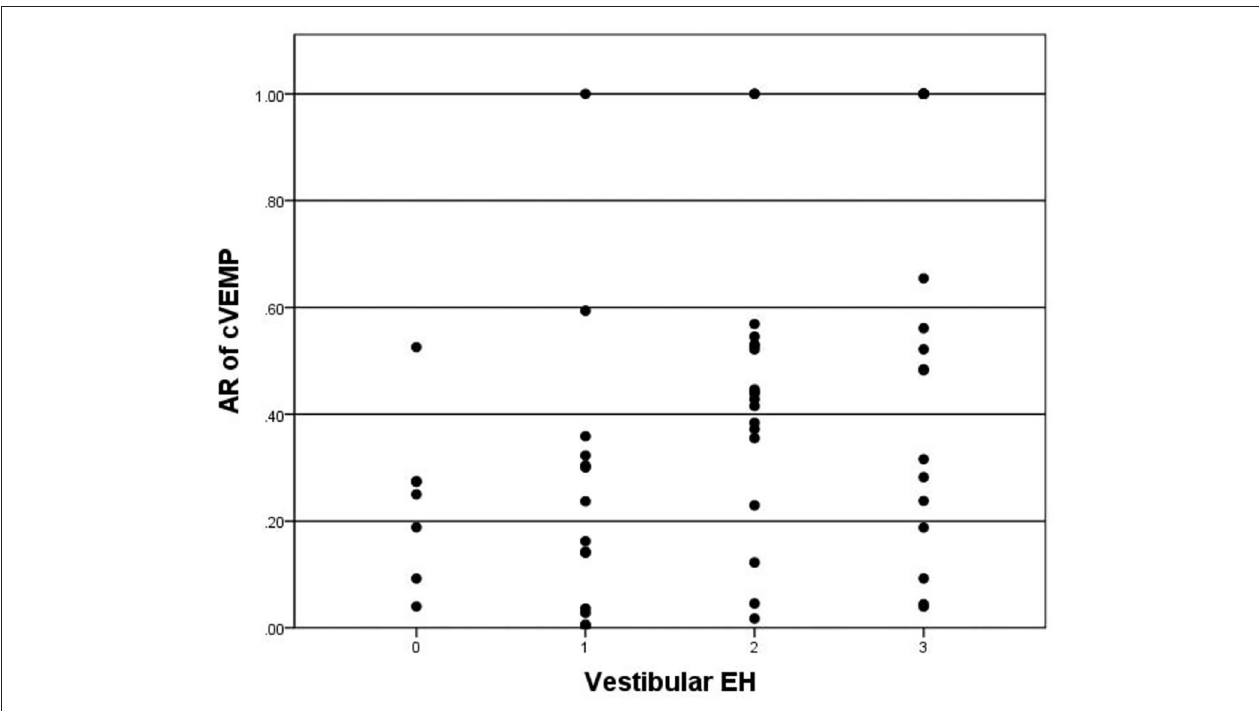
FIGURE 3 | Correlation between grade of vestibular EH (x-axis) and AR of cVEMP (y-axis). The positive correlation is significant ( r = 0.407, p = 0.001).